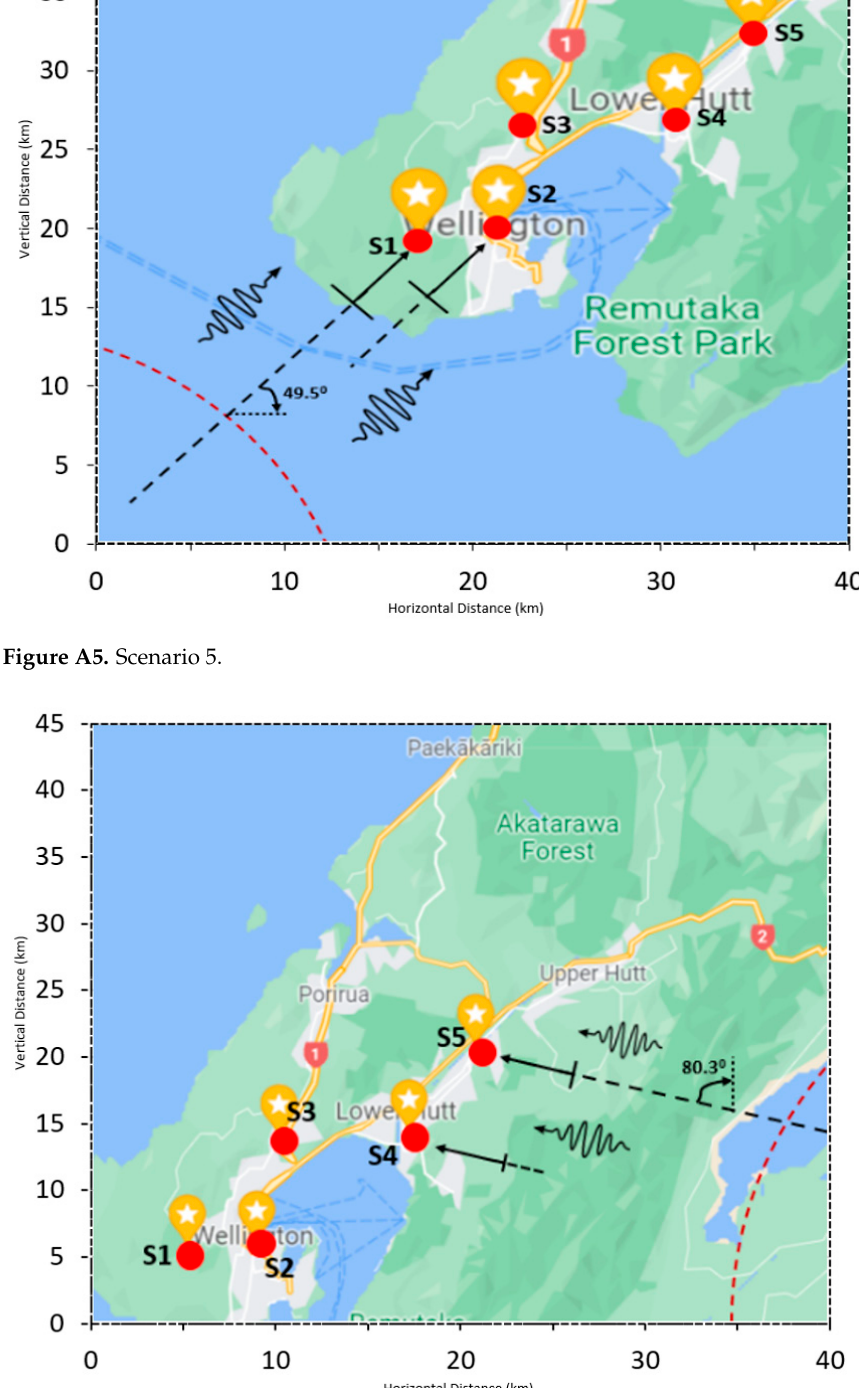
Figure A6. Scenario 6.